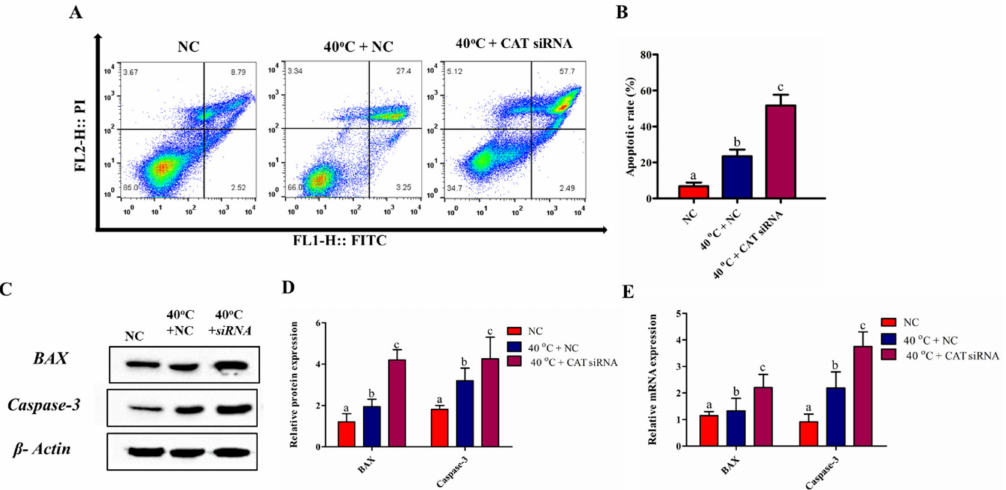
Figure 5. CAT regulates GCs apoptosis under HS. Apoptosis events were determined by FACS analysis after PI / annexin V staining in the GCs ( A , B ). The expression of BAX and Caspase-3 proteins were analyzed by Western blotting ( C , D ). β - Actin was used as a housekeeping gene. Similarly, the mRNA expression of BAX and Caspase-3 from GCs of the NC and treated groups (40 ◦ C + NC and 40 ◦ C + CAT si RNA) were evaluated by RT-qPCR. GAPDH was used as a reference gene ( E ). Values are expressed